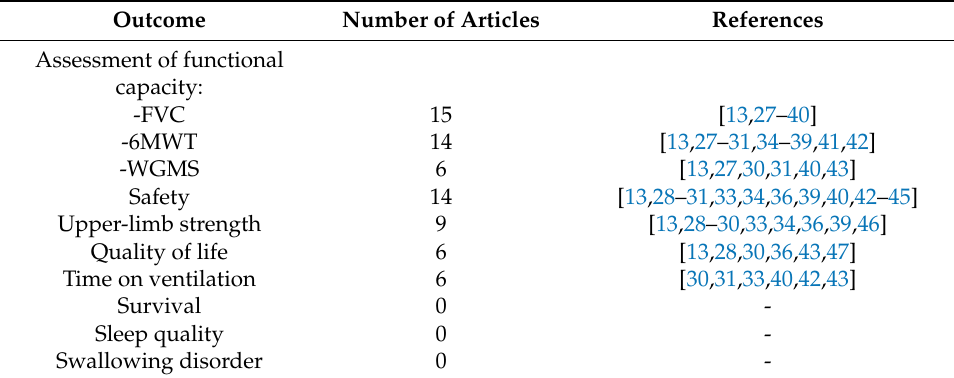
Table 2. Outcomes of interest defined a priori and studies that met the inclusion criteria.